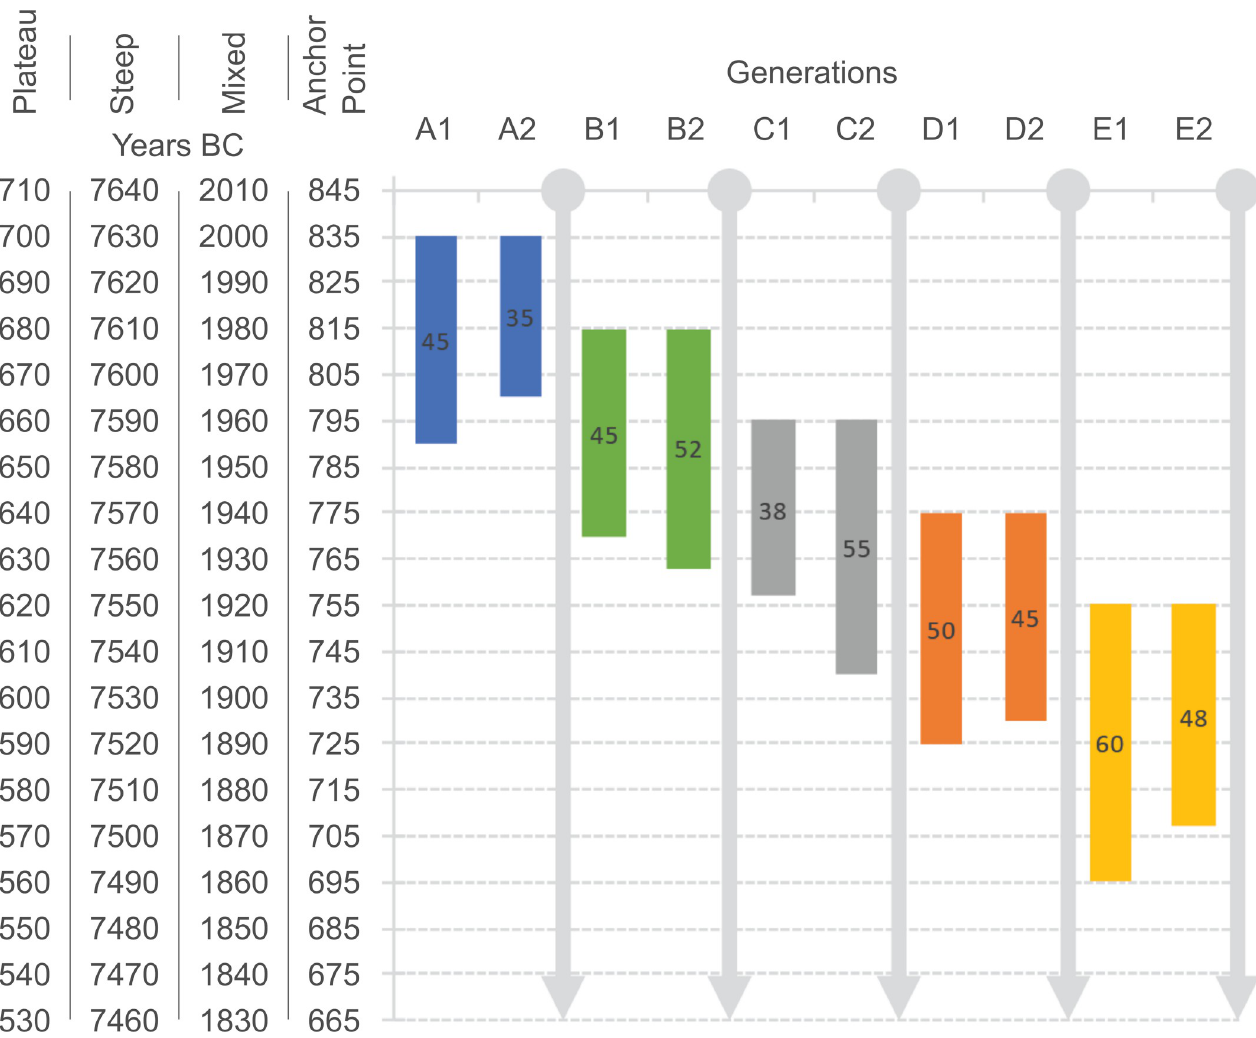
Fig 3. Graphical representation of the four simulated prehistoric single-strand pedigrees that are used for the simulations. A 20-year difference of YoB from one generation to another is prescribed. The AaD of each individual is indicated inside the coloured bars. The prescribed YoB for each of the general-type simulations (plateau, steep, mixed and anchor point) are shown on the left axis. The YoD is calculated from adding up YoB and AaD. The colour scheme of the generations is maintained in the following figures. The actual age parameters are listed in Fig